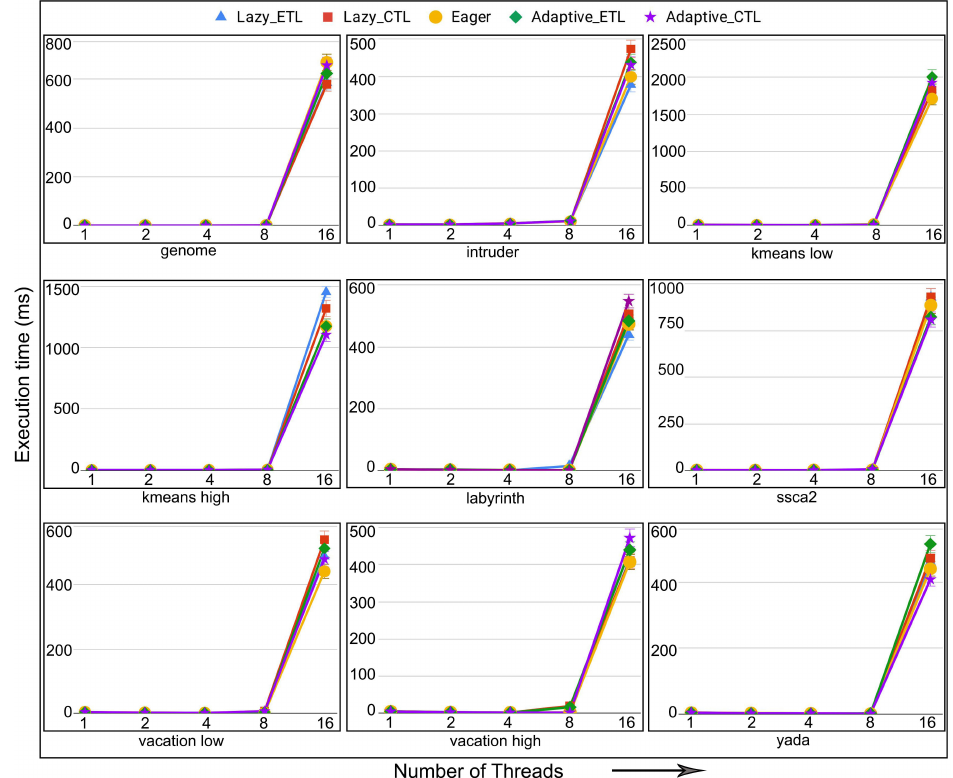
Figure 17. Execution time in STAMP benchmarks executing in persistent TM.